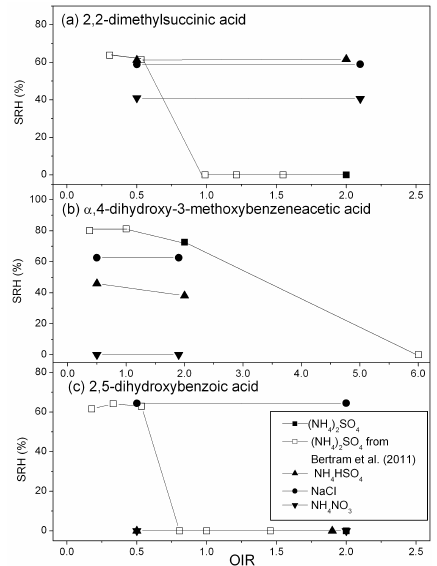
Fig. 5. Summary of SRH results as a function of OIR for the fol- lowing types of particles: (a) 2,2-dimethylsuccinic acid and inor- ganic salts, (b) α ,4-dihydroxy-3-methoxybenzeneacetic acid and inorganic salts, and (c) 2,5-dihydroxybenzonic acid and inorganic salts. Closed symbols represent results from the current study, while open squares represent results from previous studies by Bertram et al. (2011). Uncertainties in the SRH measurements have been left off for